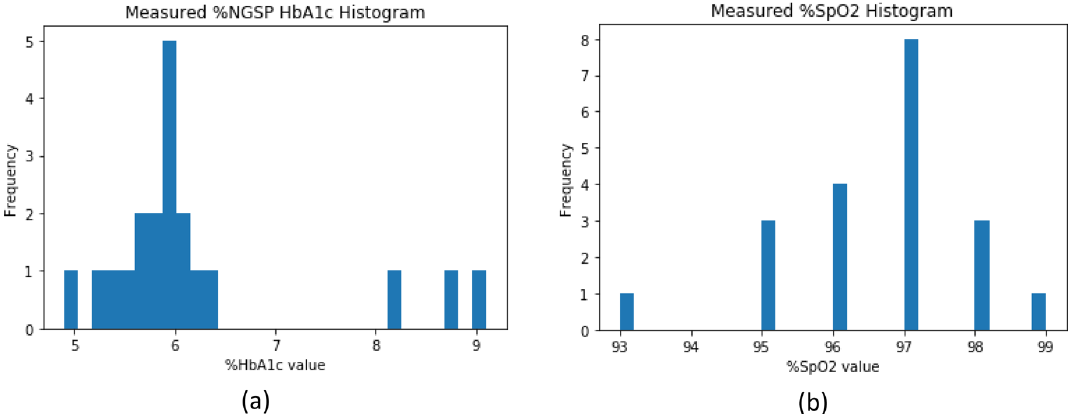
Figure 8. Histogram plot of the measured dataset ( a ) %NGSP HbA1c value and ( b ) %SpO 2 value.